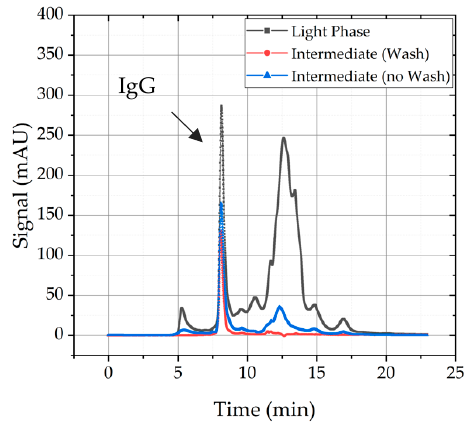
Figure 9. Comparison of SEC ‐ chromatogram of light phase (black), intermediate product produced with a washing step (red), and the intermediate without a washing step (blue).